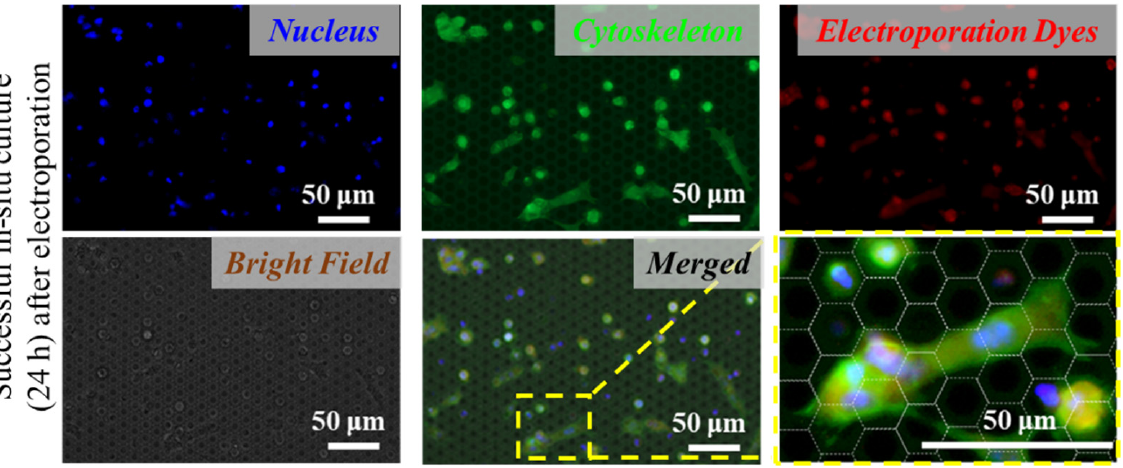
Figure 3. Good adhesion and spreading of the tumor cells on the PERFECT filter indicate successful in situ long-term (24 h) culture after electroporation.